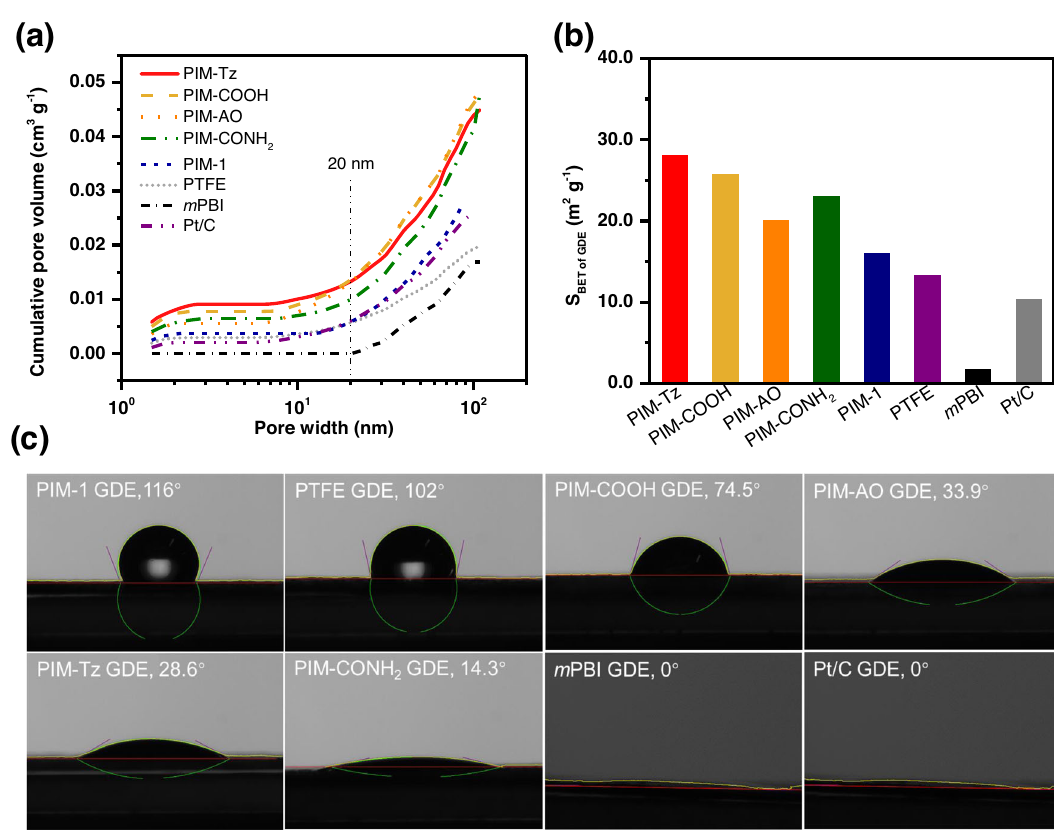
Fig. 3 | Characteristics of the GDEs with PIMs as binders in the catalyst layer. a Pore-size distributions of GDEs with various binders as indicated in the fi gure. b S BETofGDE of GDEswithdifferent bindersmeasuredbyN 2 adsorptionisothermat